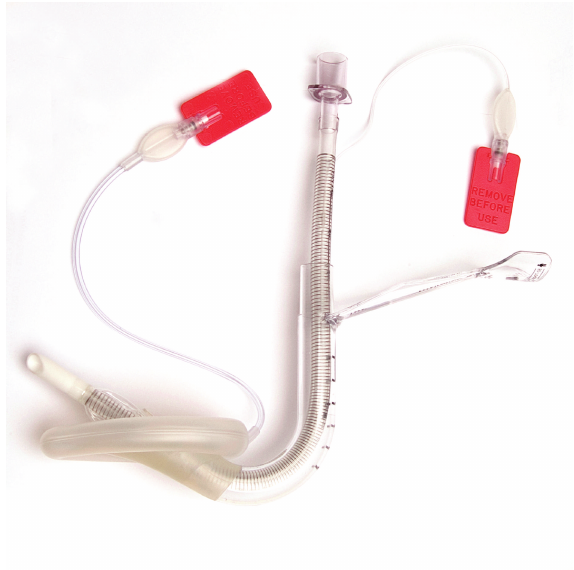
Figure 1: The single-use LMA Fastrach (LMA North America Inc., San Diego, Calif, USA) with its dedicated single-use reinforced tracheal tube (image courtesy of The Laryngeal Mask Company Limited, Jersey, Channel